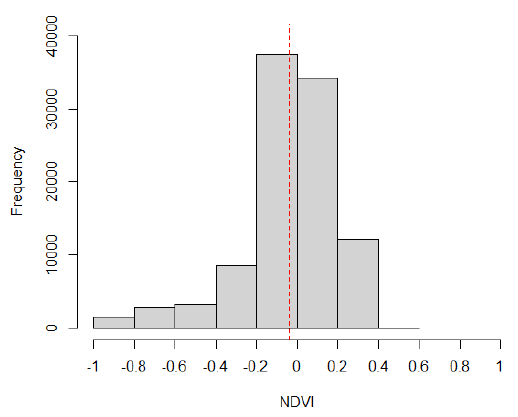
Figure 8. Histogram of segment areas for segments smaller than 10 m 2 . Red dashed line is the mean segment area